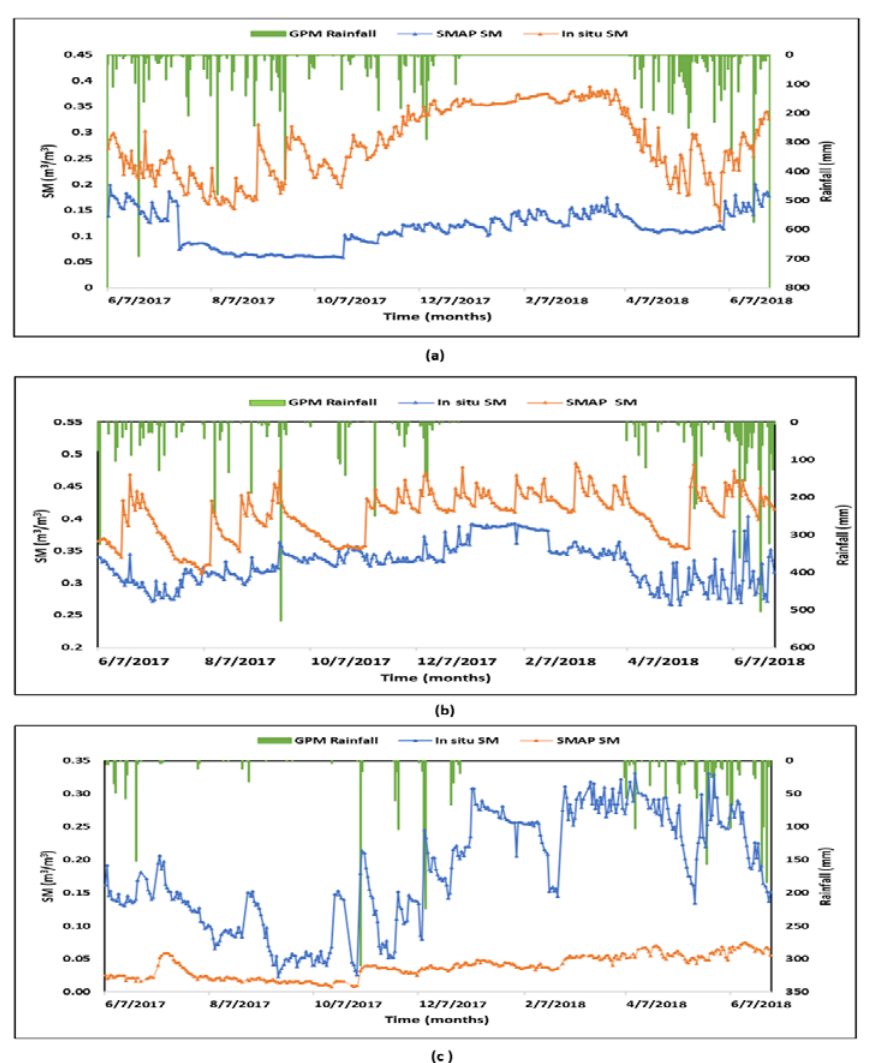
Figure 6. Temporal series plot between the SMAP SM, in situ SM and GPM rainfall for ( a ) Dumbraveni, Romania ( b ) Feldbach, Austria and ( c ) El Coto, Spain, Europe.